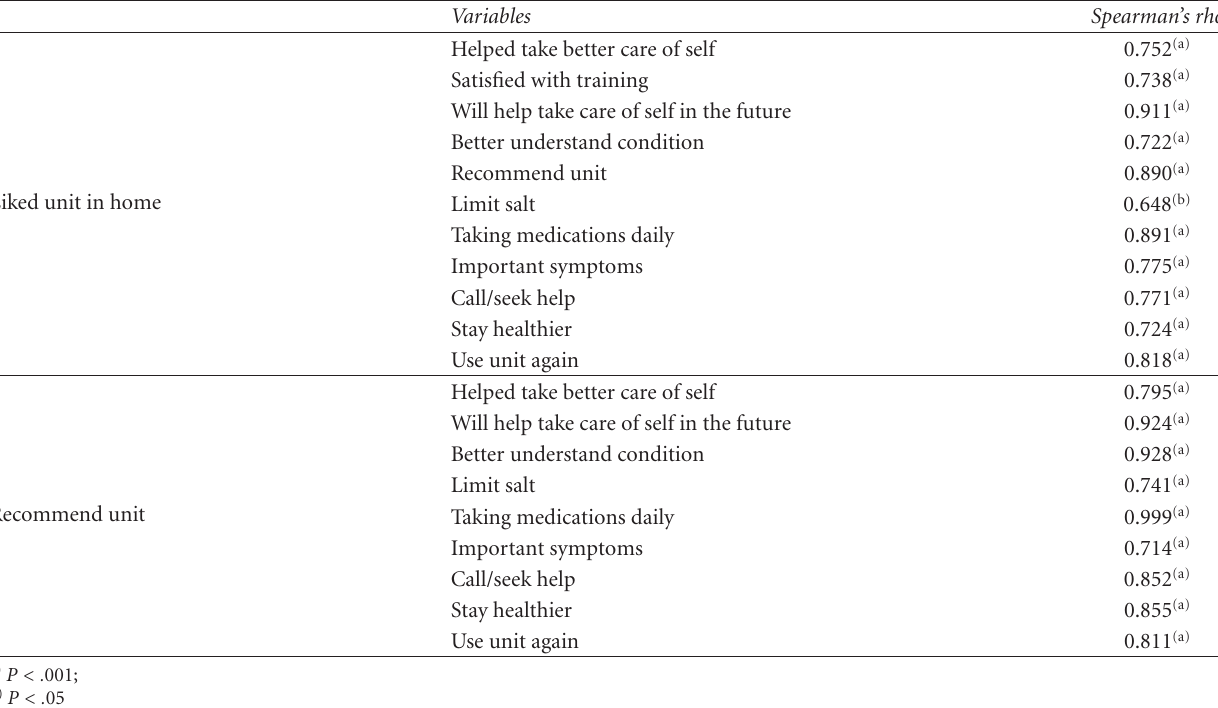
Table 5: Correlates: perspectives regarding the telemedicine unit.